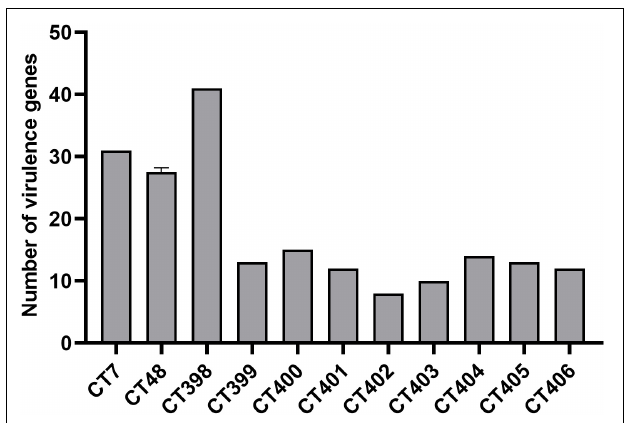
FIGURE 7 | Invasion of Caco-2 cells by different strains of STEC. The same letter indicates that there was no significant difference between each other, and the absence of the same letter indicates that there was a significant difference between each other ( p < 0.05). Results were expressed as percent of invasive bacteria respect to